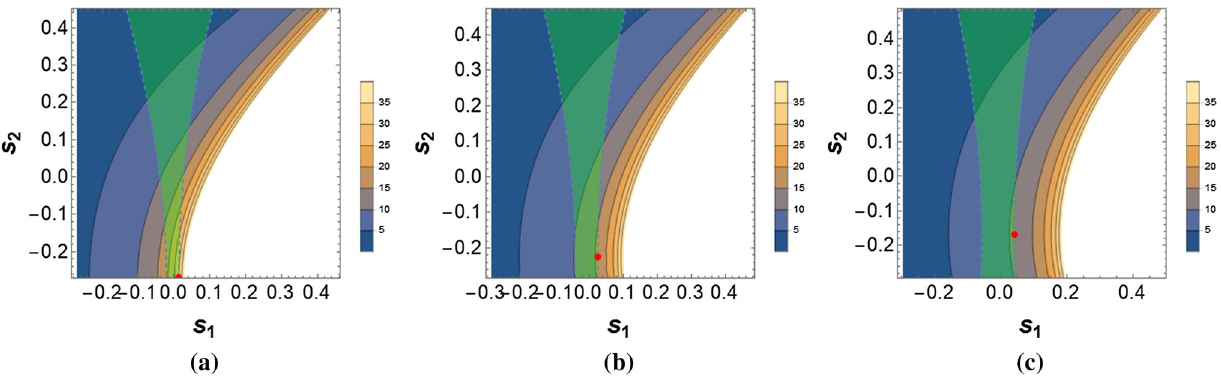
Fig. 4 The contour map of E 3 in terms of s 1 and s 2 . The time-like condition for the particle 3 orbit is satisfied in the green shaded region. The maximum value of E 3 is obtained at the red point. a When b = 0, η = E / 2 ≈ 15 . 01 at ( s = 0 . 01378 , s = − 0 . 2679 ) ; b when max 3 max 1 2 Fig. 5 a The relation between ξ and β 3 for different value of b when E 2 = 1. The other parameters are chosen for giving the maximal value of E 3 . When b = 0, s 1 = 0 . 01378 and s 2 = − 0 . 2679; When b = 0 . 1, s 1 = 0 . 0269 and s 2 = − 0 . 225; When b = 0 . 2, s 1 = 0 . 0408 and s 2 = − 0 . 168; b the relation between maximum efficiency η = E / 2 and max 3 max